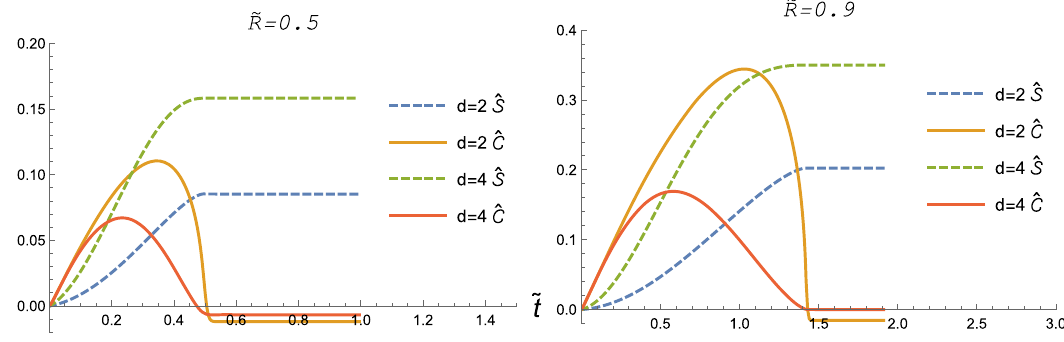
Fig. 5 Time evolution of HEE and ˆ C for fixed d . The mass parameter is fixed as M =